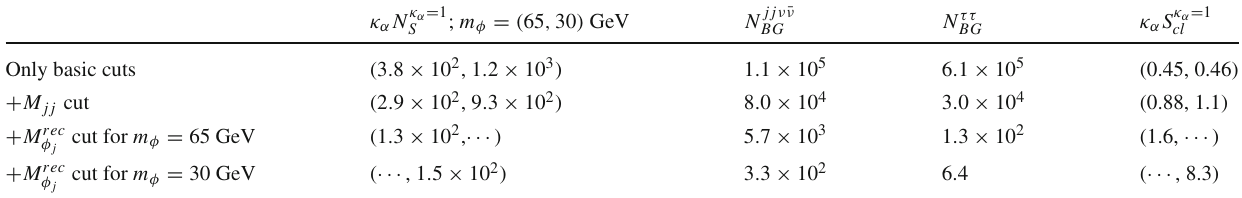
Fig. 9 Distribution of reconstructed ϕ mass after imposing basic and M jj cuts where left-, middle- and right-panels correspond to signal, jj ν ¯ ν BG and τ + τ − BG events. Here κ α = 1 is applied Table 4 The number of events for signal ( N S ), BG ( N BG ) and significance ( S cl ) for RR polarization after each cut where the setting is the same as Table.